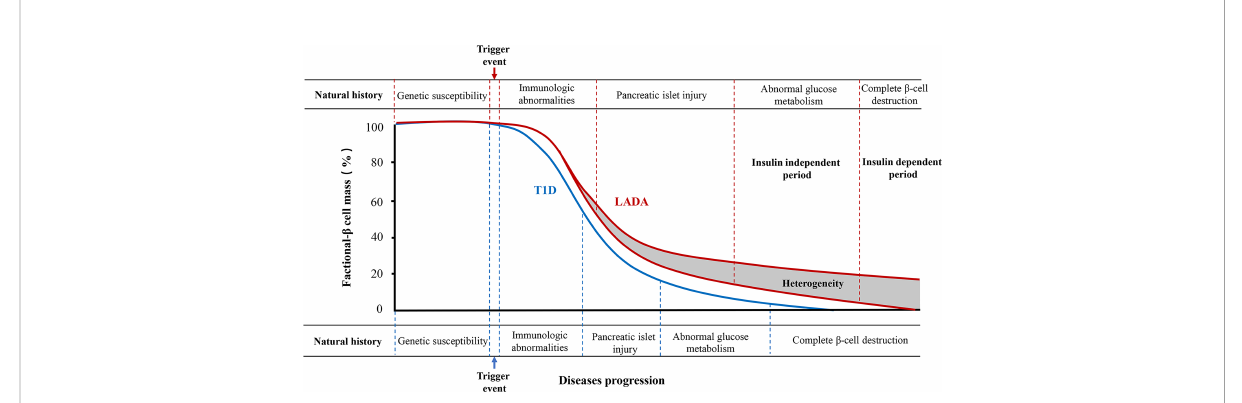
FIGURE 1 The natural history of type 1 diabetes and LADA. Type 1 diabetes can be divided into six stages. LADA has a similar natural course to type 1 diabetes as its autoimmune subtype. However, the rate of decline of pancreatic b -cell function is lower than that of type 1 diabetes. Moreover, the natural history of most LADA patients can be divided into insulin-independent and insulin-dependent periods according to the degree of pancreatic b -cell destruction. There is great heterogeneity in the progression to insulin dependence in patients with LADA, which is associated with the age of onset, body mass index, genetic background, and immune, lifestyle, and environmental